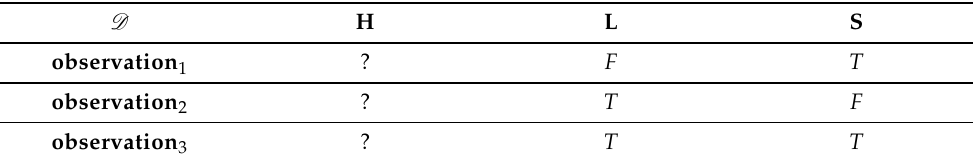
Figure 4. Bayesian network for information aggregation. Table 2. Incomplete datasets D .